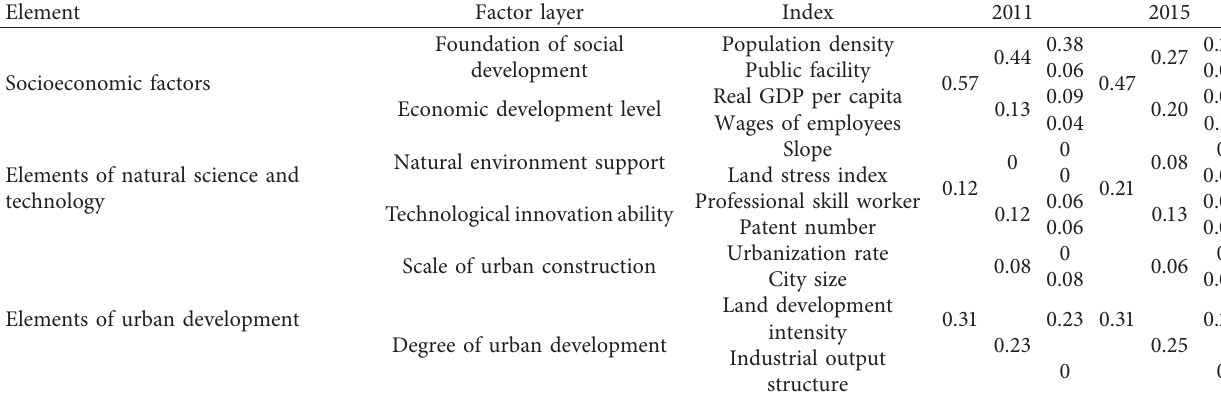
Table 5: Relative importance of each